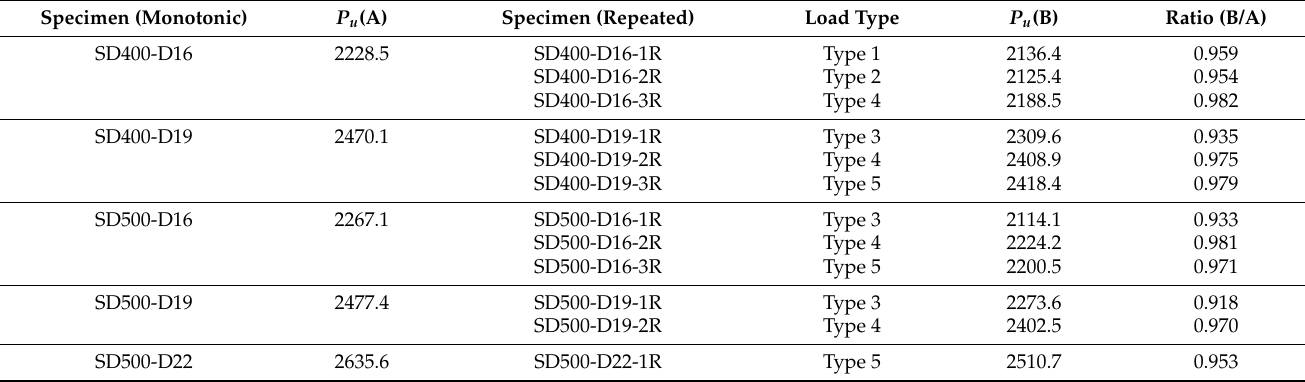
Table 10. Shear resistance degradation by repeated loads.